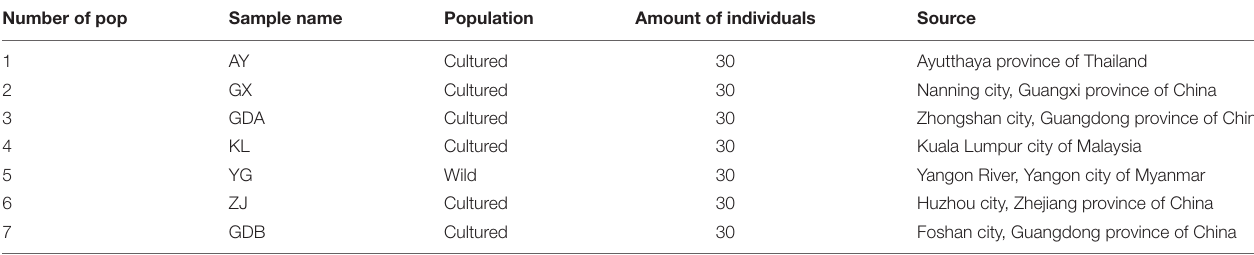
TABLE 1 | Location of populations and number of samples in each populations of M. rosenbergii . Number of